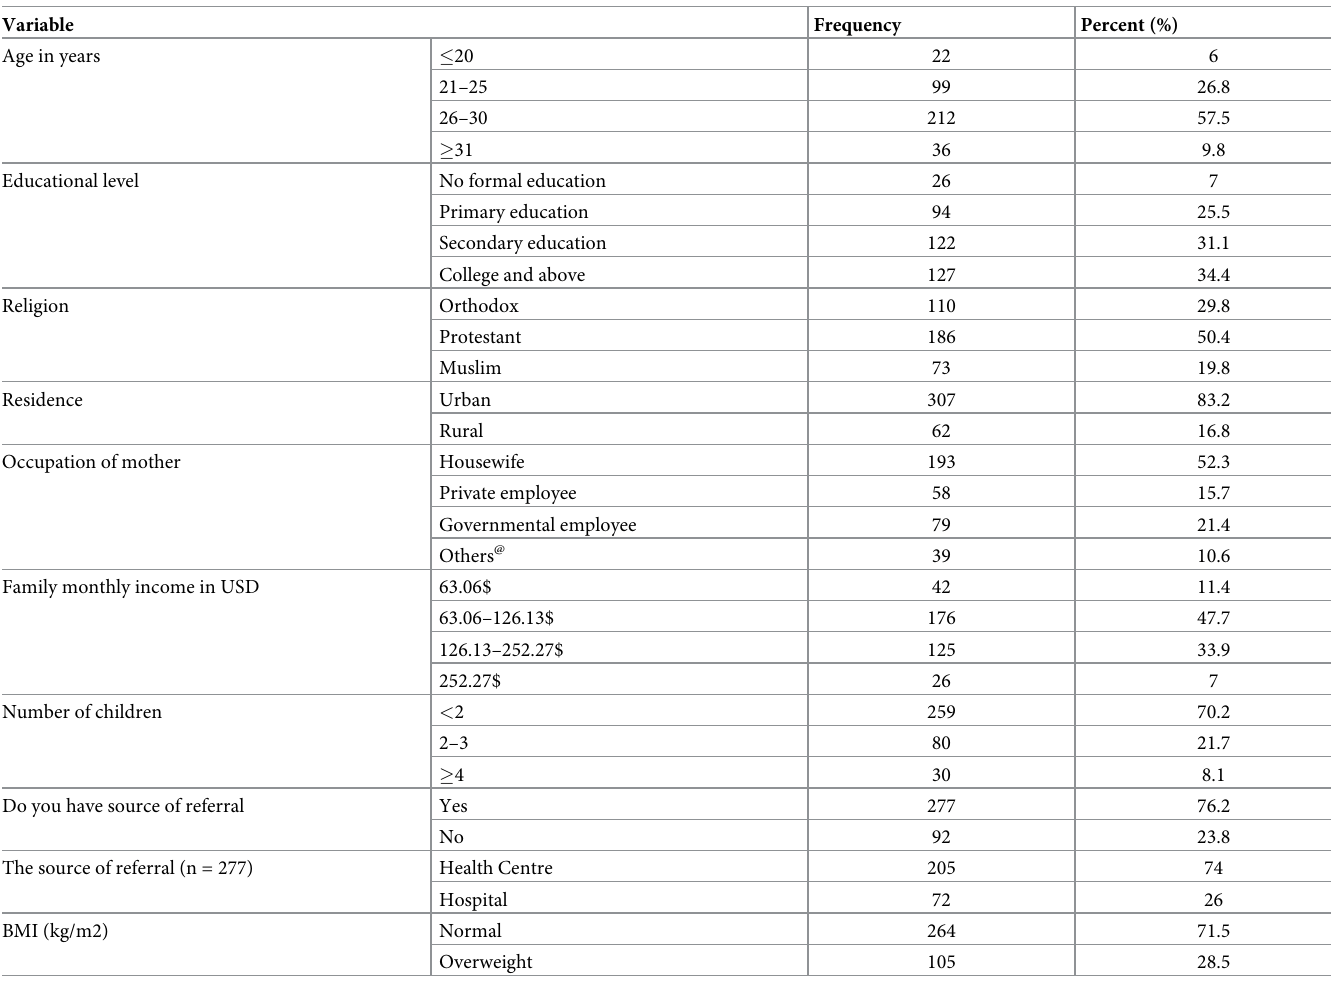
Table 1. Socio-demographic characteristics of the women on predictors of time-to-recovery from cesarean section delivery among women who gave birth by CS at HUCSH, 2020 (n =